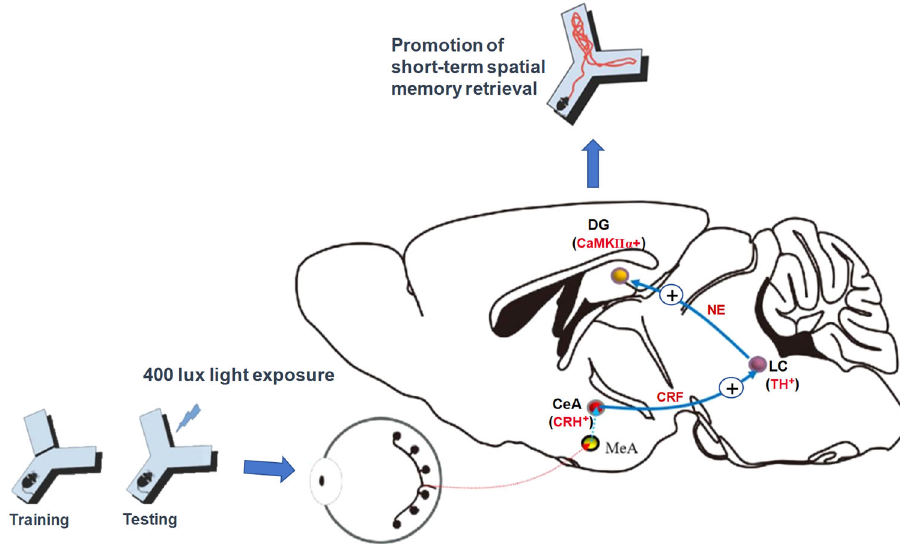
Fig. 8 Light exposure of 400lux could promote memory retrieval by activating CeA-LC-DG circuit. In this process, light increased the activity of CeA - CRH + neurons which release CRF and activate LC - TH + neurons. TH + neurons in LC release NE and increase the activity of CaMKII α + neurons in DG through LC-DG circuit, thus promoting short-term spatial memory